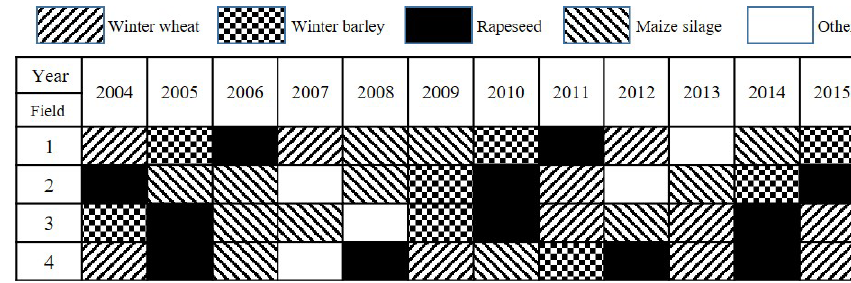
Figure 2. Crop rotations during the investigation period and for all